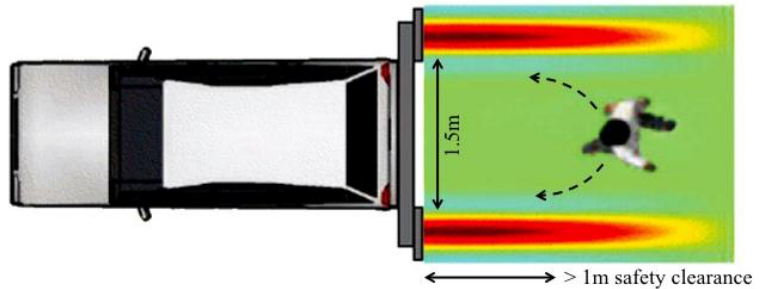
Figure 1. Schematic representation of the guiding system: two transmitting antennas, set on a mobile unit, generate two EM walls delimiting a virtual hallway that can guide the running athlete, properly equipped with the receiving system, along whatever